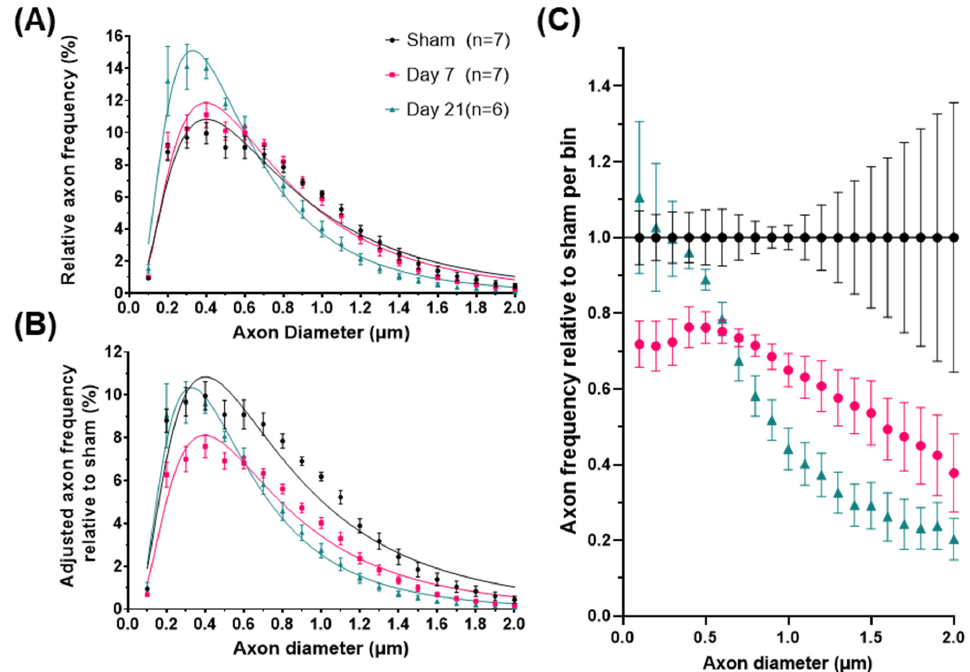
Figure 2. Axonal diameter distribution changes in the corticospinal tract after impact-acceleration traumatic brain injury. ( A ) Relative frequency plots of axon calibers (Feret’s diameter) at 7 or 21 days after injury or sham injury, fitted with lognormal curves. ( B ) Adjusted frequencies relative to the sham injury group (area under the curve represents total axon survival). ( C ) Estimated relative axon frequency per axon diameter bin, compared to sham-injured animals. Error bars represent standard error of the mean for each group.